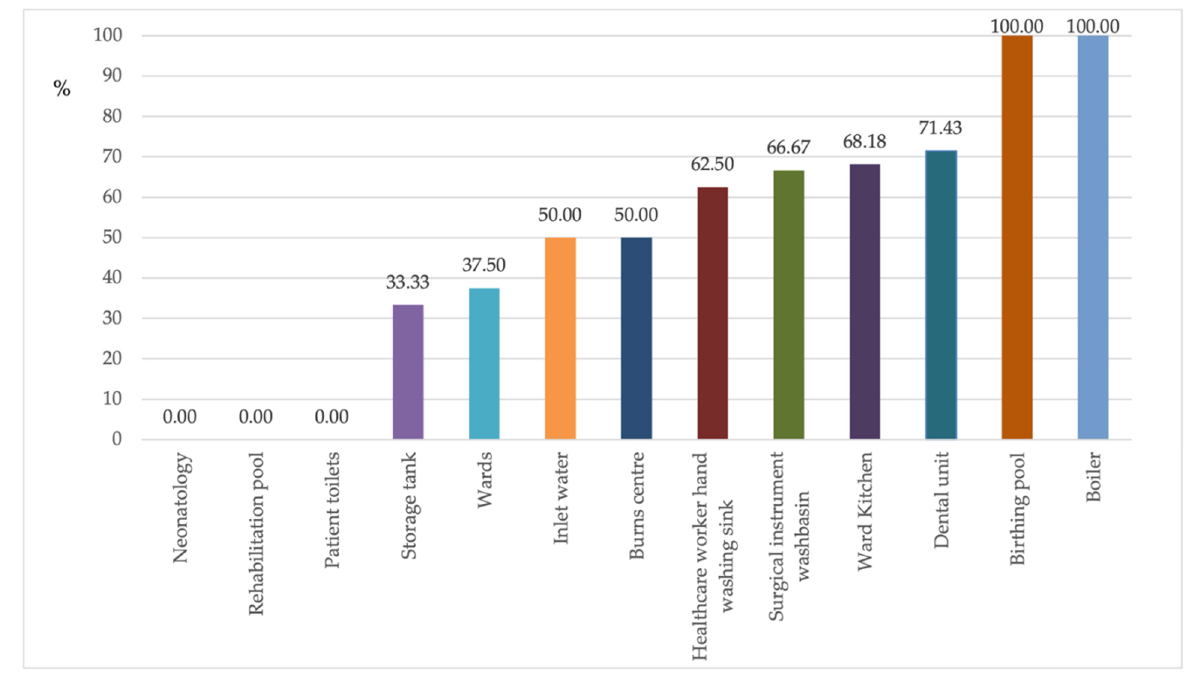
Figure 1. Percentage of antibiotic-resistant P. aeruginosa in the individual sampling sites. Of the resistant isolates, only 20.75% were resistant to one antibiotic and 22.64% were resistant to two or three antibiotics. A decreasing percentage of isolates showed resistance to more than three antibiotics. In total, 1.89% of the resistant isolates were resistant to eight of the eleven antibiotics tested (Figure 2) and came from the water circuit of a hospital ward kitchen.